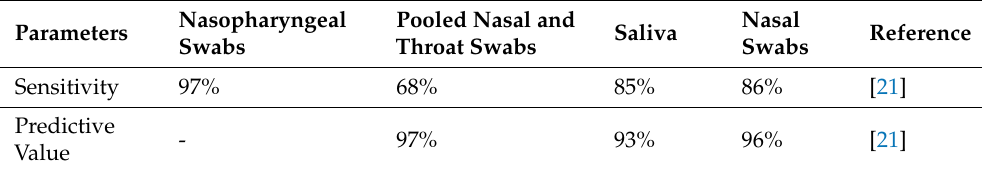
Table 1. Comparing sensitivity and predictivity of different sampling